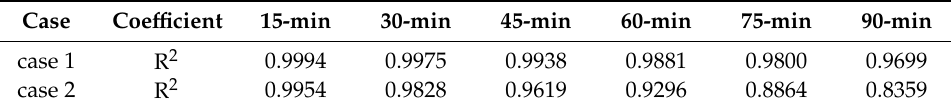
Table 3. The coe ffi cient of determination R 2 .